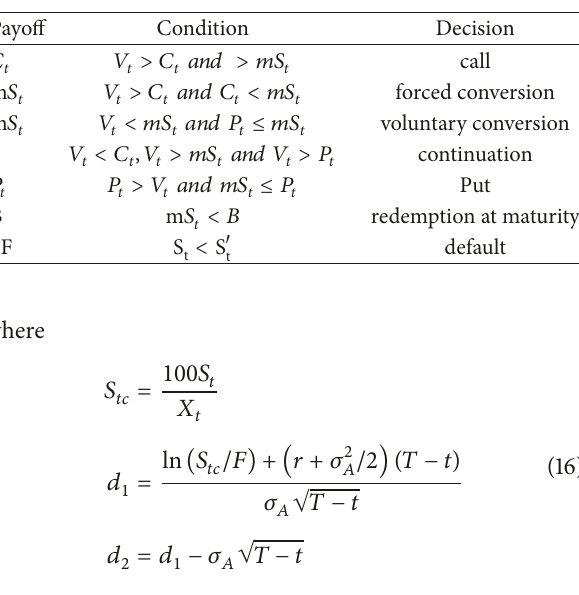
Table 1: Rules of optimal exercise decision in convertible